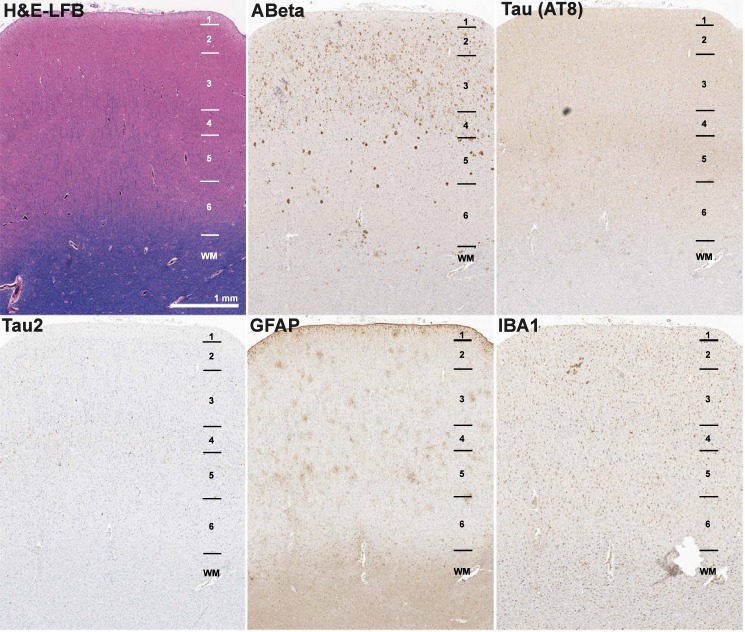
Example of FFPE pathology in donor H14.09.075.Examples of histology from FFPE temporal cortex of donor H14.09.075 using IHC for Ab6E10 (Aβ), AT8 (paired helical filament pTau), Tau2 (pTau), GFAP (astrocytes), and IBA1 (microglia), and ThioS labeling, showing severe Aβ and pTau pathology. FFPE pathology measurements are relatively dim compared with fresh frozen, but can still be quantified. Numbers indicate cortical layers.